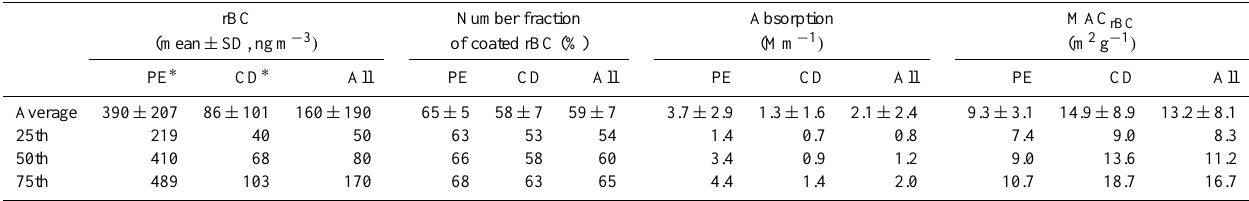
Table 1. Summary of rBC concentrations, the number fraction of coated rBC, light absorption coefficient, and mass absorption cross section of rBC (MAC rBC ) during different sampling